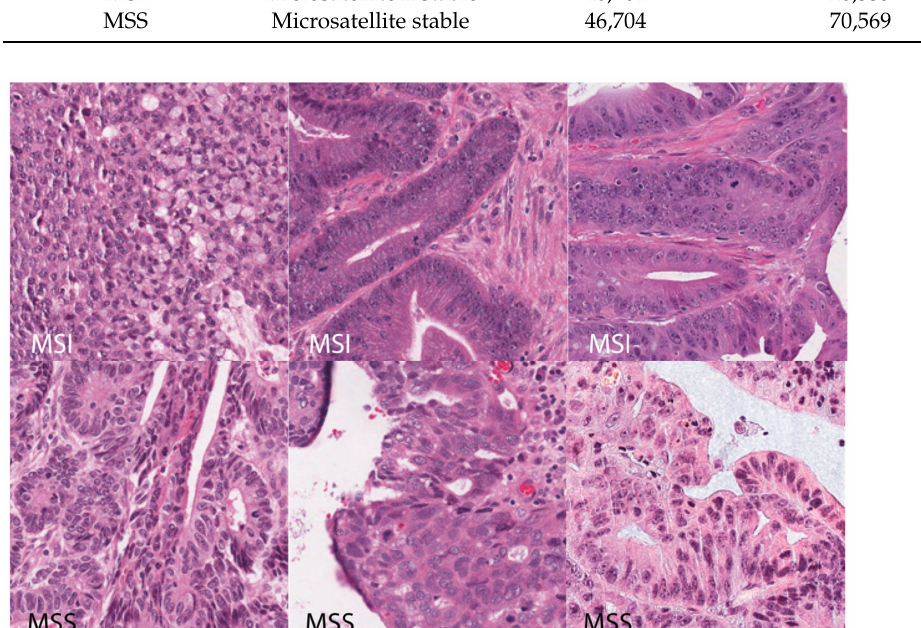
Figure 5. Examples of Kather et al. [22]’s images in the MSI vs. MSS test set and their corresponding labels. Table 4 shows class names and number of samples in the